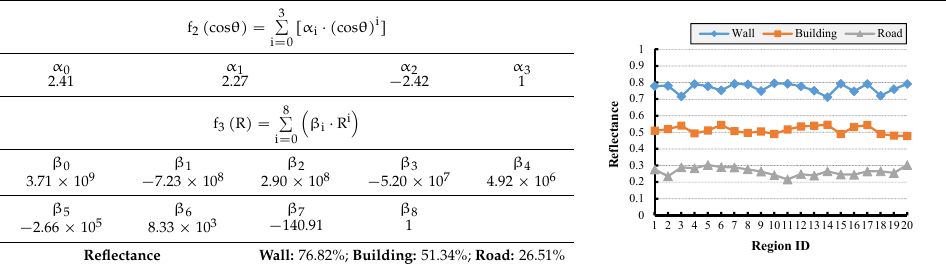
Figure 9. Absolutely corrected intensity values of the sampled regions of the three surfaces. ( a ) The 80% target is used as a reference; ( b ) The 60% target is used as a reference; ( c ) The 40% target is used as a reference; ( d ) The 20% target is used as a reference. Table 7. Absolute correction results (reflectance) of the three surfaces when different reference targets are used.